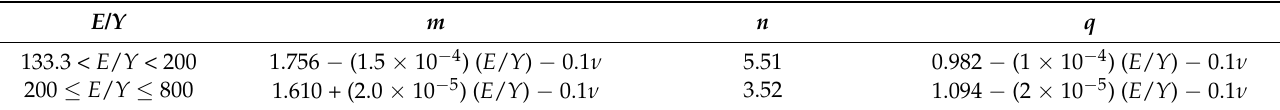
Table 4. Parameters in Equations (9) and (10).